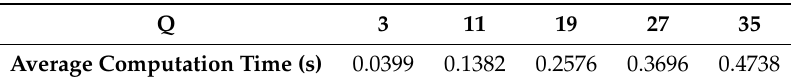
Table 2. Average computation time for different values of the parameter Q .